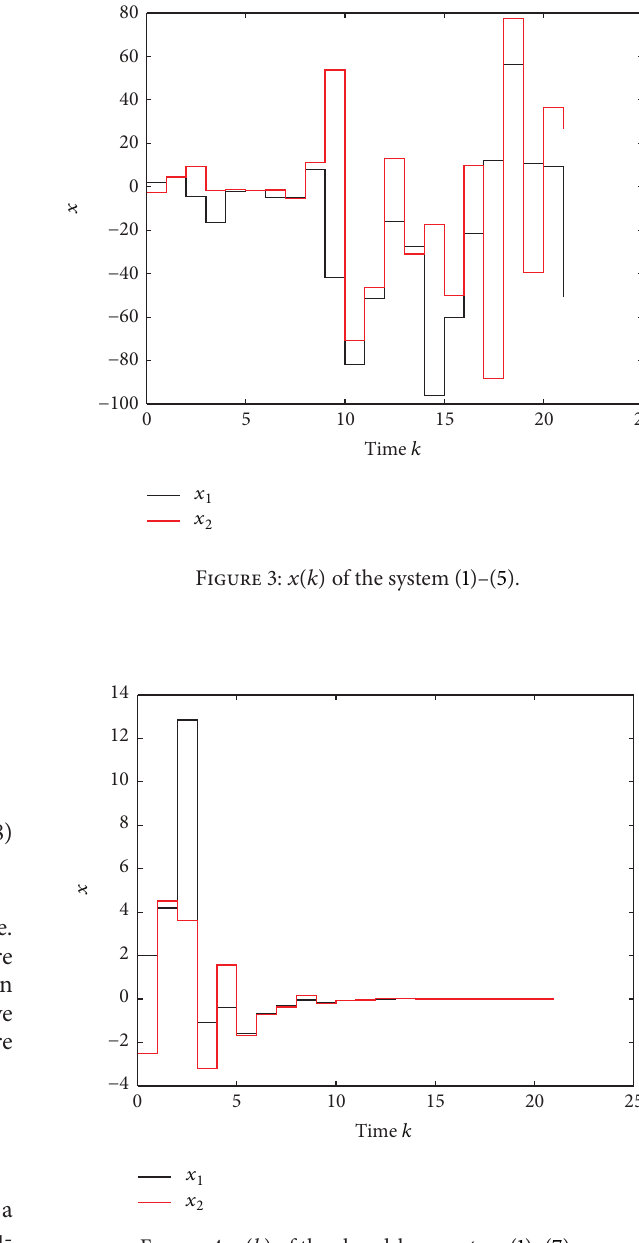
Figure 4: 𝑥(𝑘) of the closed-loop system